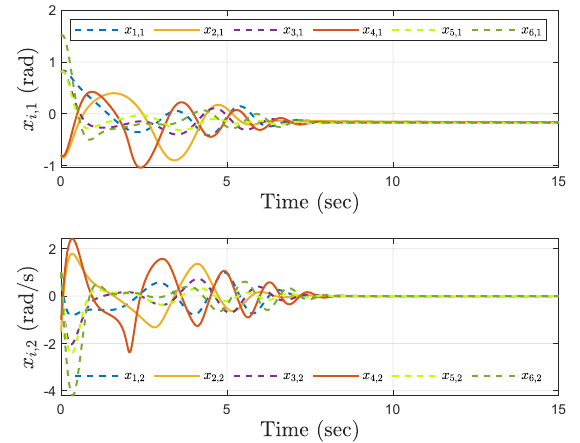
Figure 11. Trajectories of the angles x i ,1 and the velocities x i ,2 under the time − triggered control.